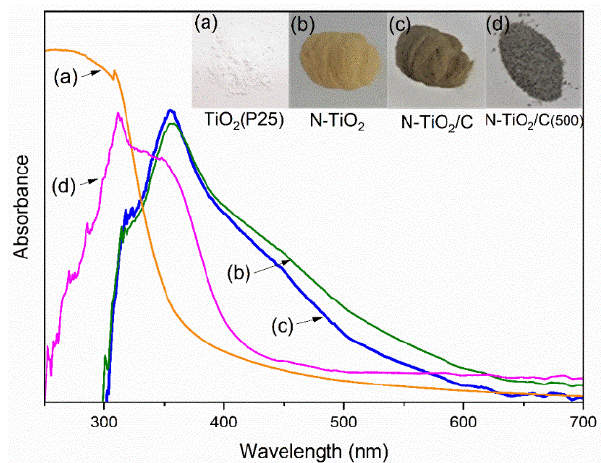
Fig. 6. X-ray diffraction (XRD) pattern of (a) N-TiO Fig. 6. X‐ray diffraction (XRD) pattern of (a) N‐TiO 2 /C and (b) N‐TiO 2 /C(500)